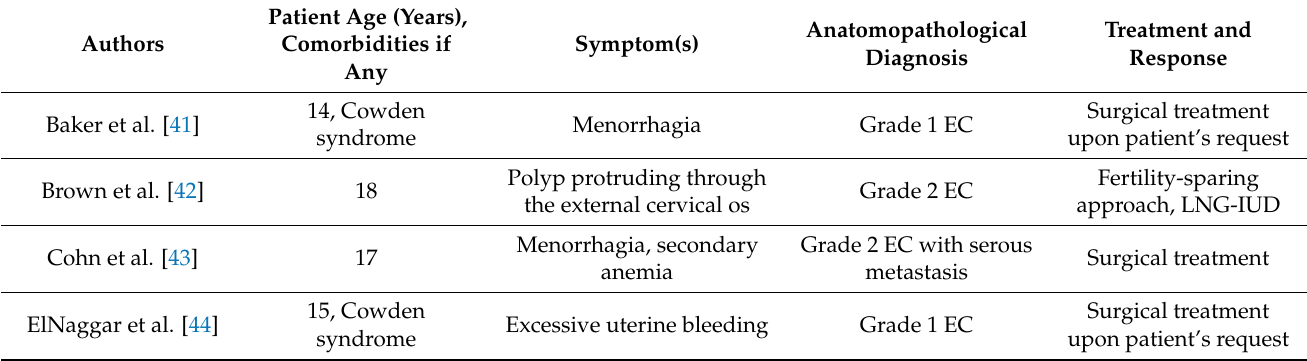
Table 1. A summary of the world literature on patients diagnosed with EC using contemporary diagnostic criteria and described in sufficient or reasonably sufficient detail, aged 21 years or younger ( n = 19). Original descriptions of symptoms are